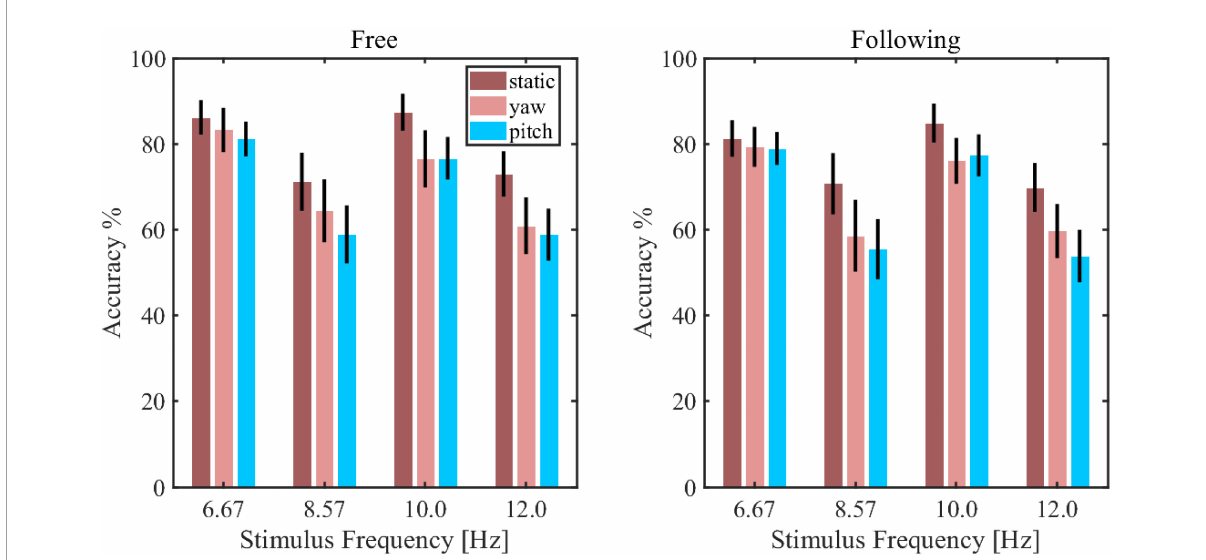
FIGURE7 The decoding accuracy of steady-state visual evoked potential (SSVEP) using the canonical correlation analysis (CCA) approach in each stimulus frequency and moving pattern.